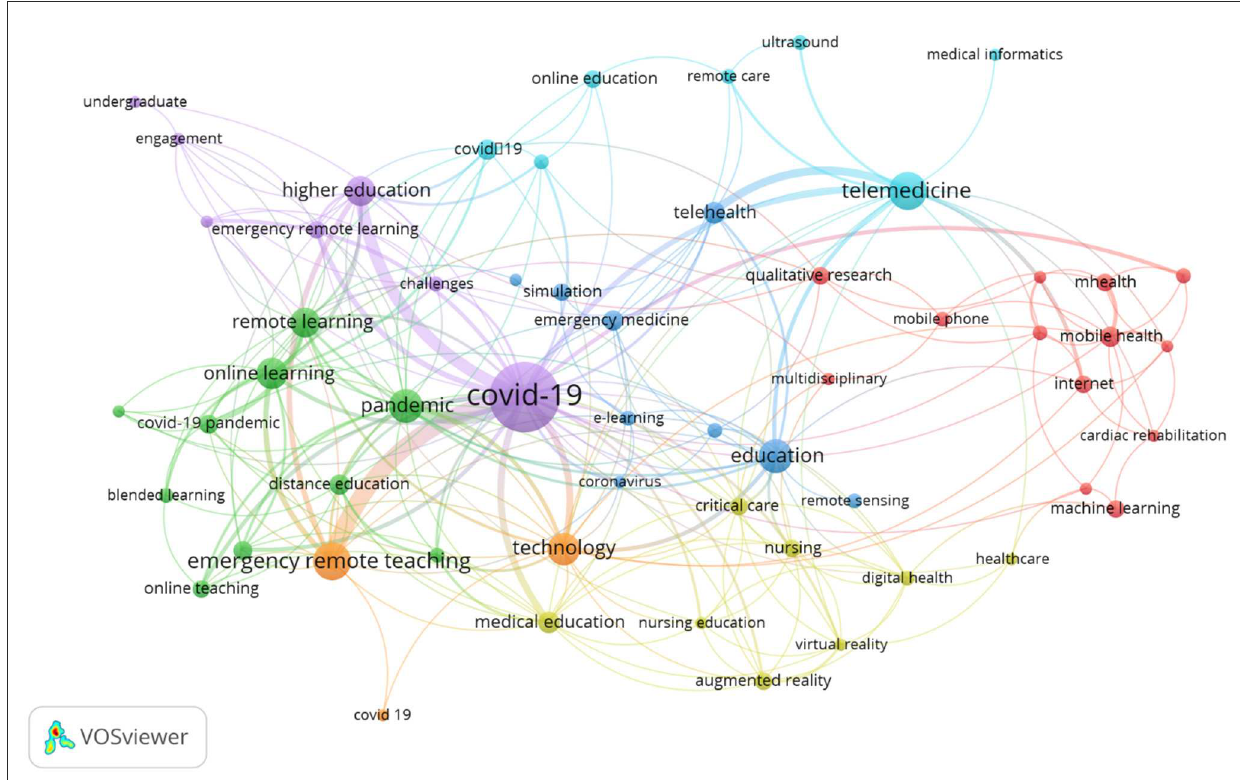
FIGURE2 The network visualization figure of the screened keywords.